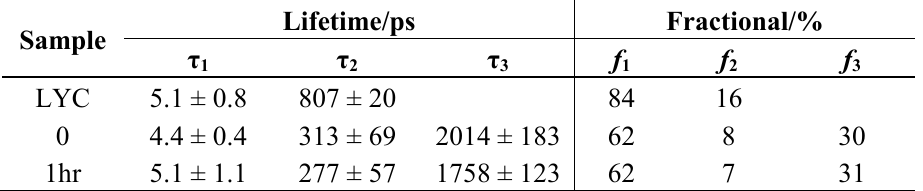
Figure 6. Representation of the decay of lycopene in hexane (red), also showing the IRF (of 36 ps—blue), fitted function (2 exponential green) and weighted residuals (green), close to the peak of the decay. The excitation wavelength was 409 nm (DD-405L) and the emission at 550 nm. Adapted from [48]. Table 1. Time-resolved decay parameters obtained using reconvolution analysis, with excitation at 409 nm and emission at 550 nm. Note, if comparing the normalised pre-exponentials ( α i ) then τ 1 accounts for practically all the